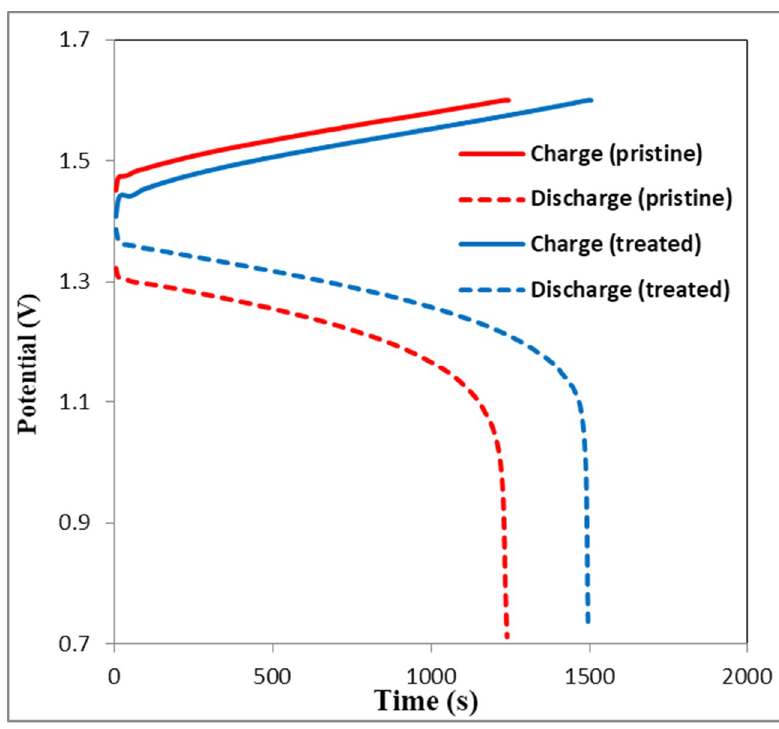
Figure 8. The comparison of second cycle charge-discharge curves of the carbon felt with and without atmospheric plasma treatments.